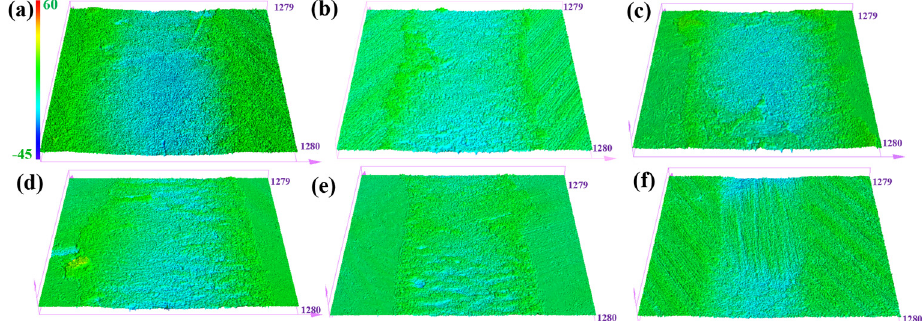
Figure 5. 3D morphologies of the worn surface of: ( a ) FGr@MoS 2 -0; ( b ) FGr@MoS 2 -0.3; ( c ) FGr@MoS 2 - 0.6; ( d ) FGr@MoS 2 -0.9; ( e ) FGr@MoS 2 -1.2; ( f ) FGr@MoS 2 -1.5.